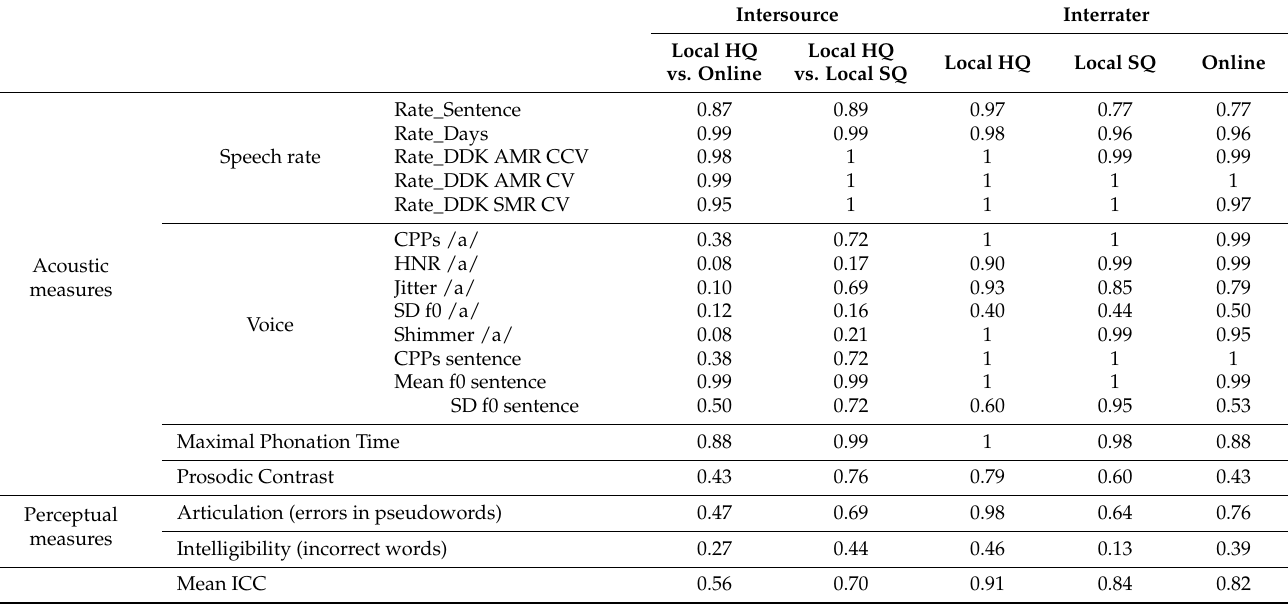
Table 5. Intraclass Correlation Coefficients for all speech